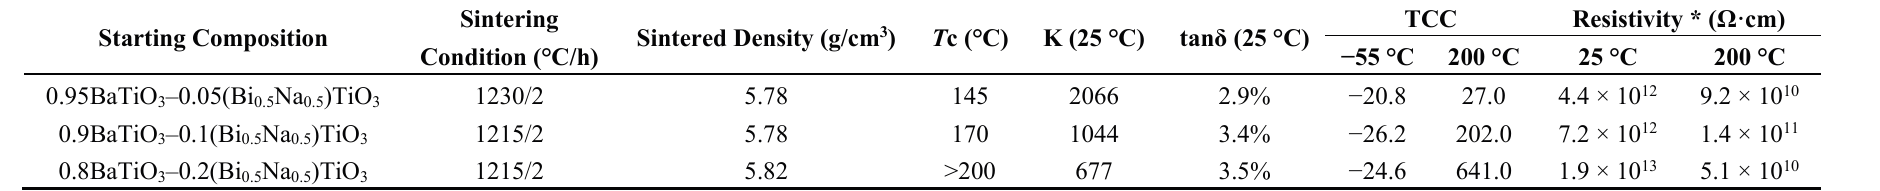
Table 1. Dielectric properties of (1 − x )BaTiO 3 – x (Bi 0.5 Na 0.5 )TiO 3 ceramics at their maximum sintered densities. Starting Composition